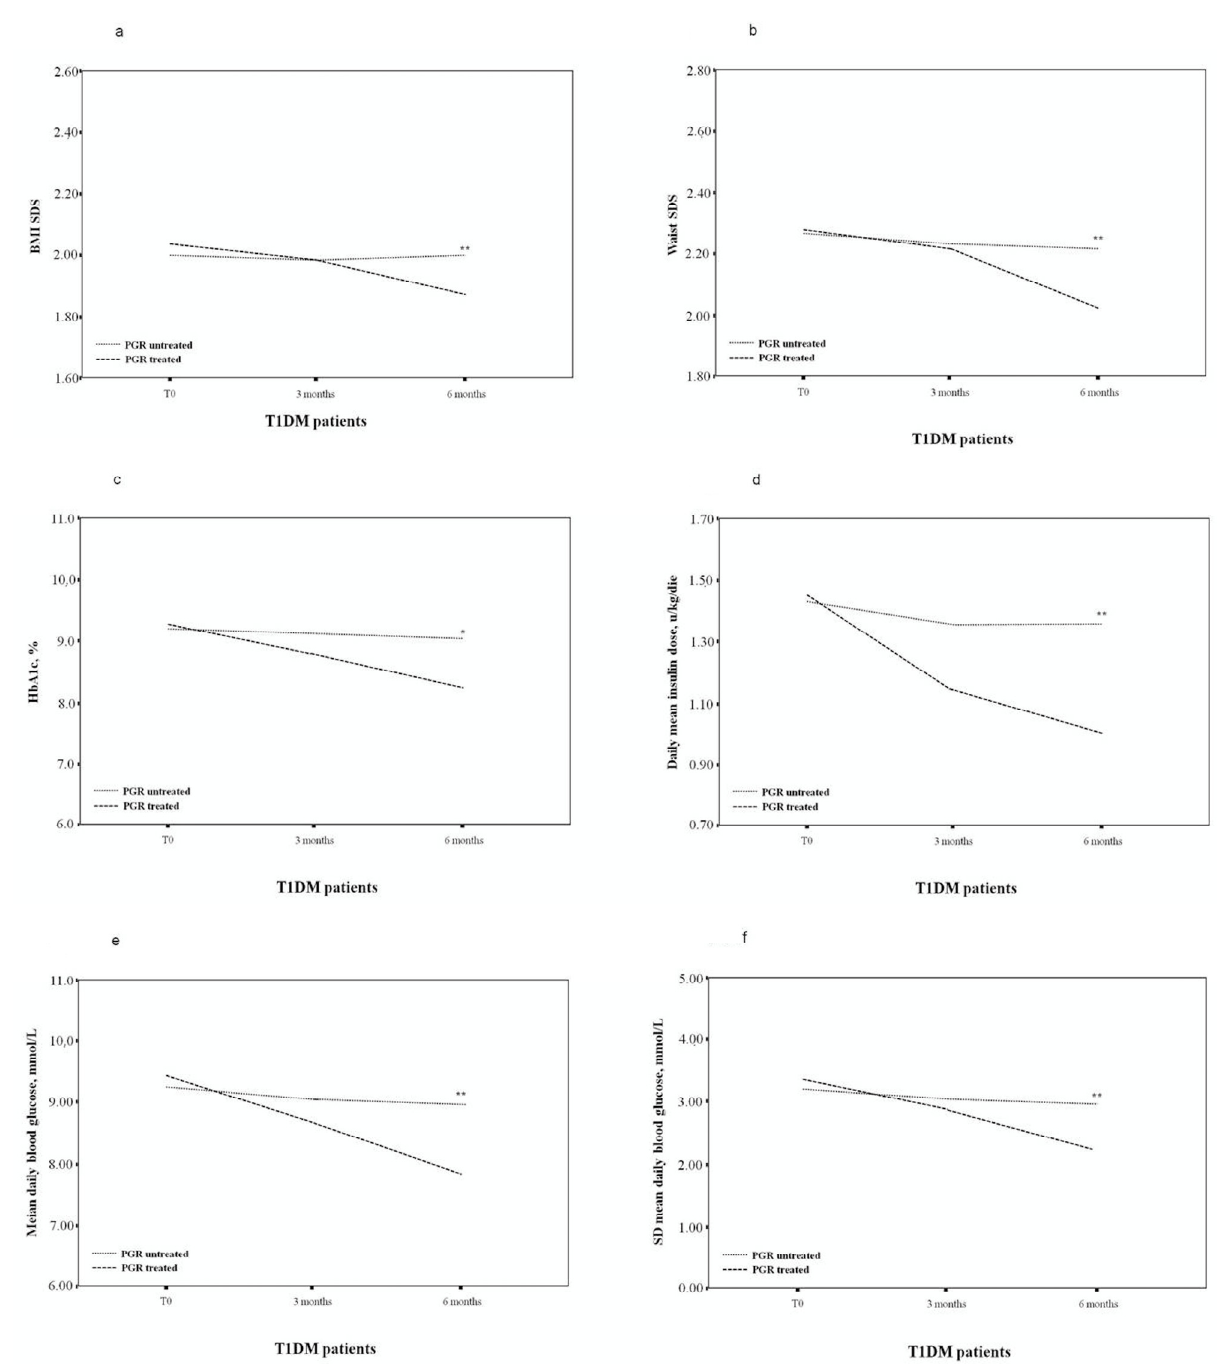
Figure 1. Body mass index (BMI) standard deviation score (SDS) ( a ), waist SDS ( b ), HbA1c, % ( c ), daily median insulin dose ( d ), mean daily BG levels ( e ), SD of the daily BG levels ( f ) of PGR-treated and untreated patients. * p < 0.05; ** p <